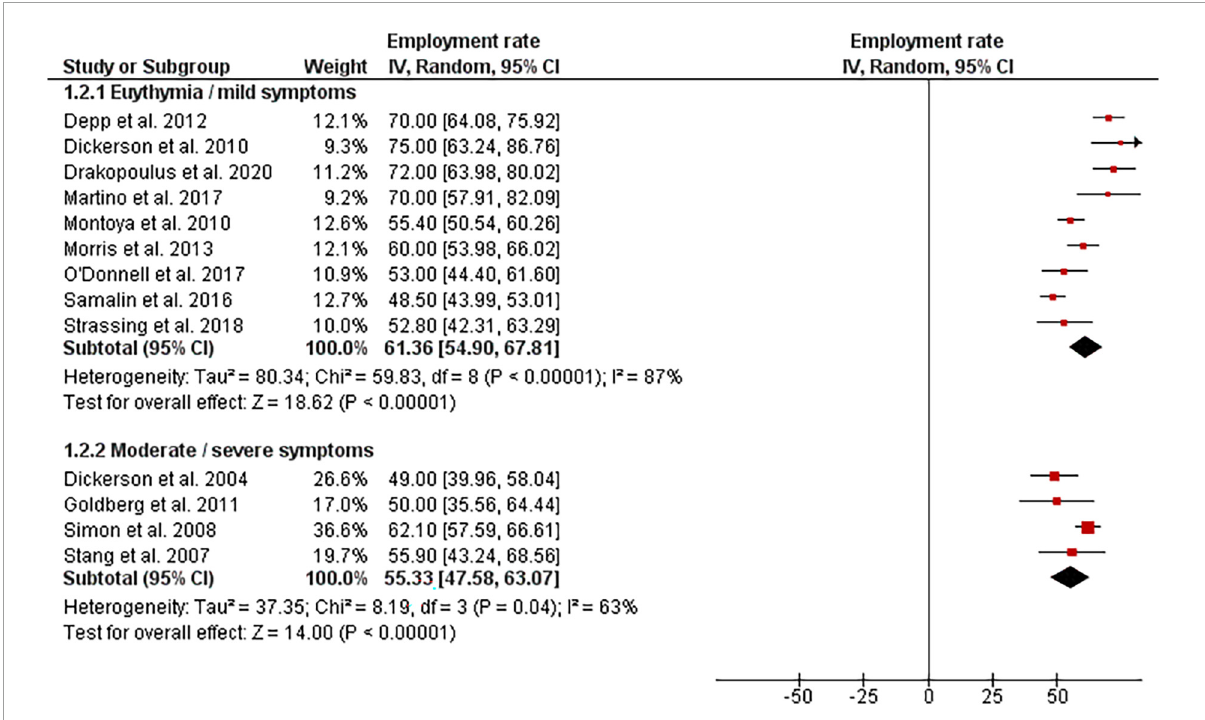
FIGURE3 Employment rate among BD population–pooled analysis with regards to study